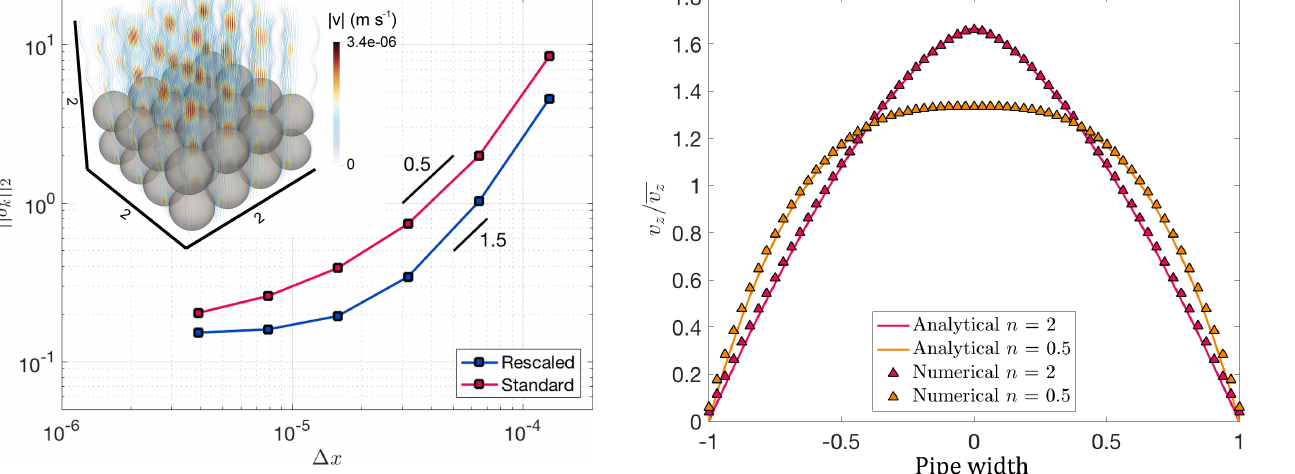
Figure 6. Comparison of analytical and numerical velocities for Hagen–Poiseuille flow with a power-law fluid. Analytical velocities are represented as colored lines and numerical velocities as colored